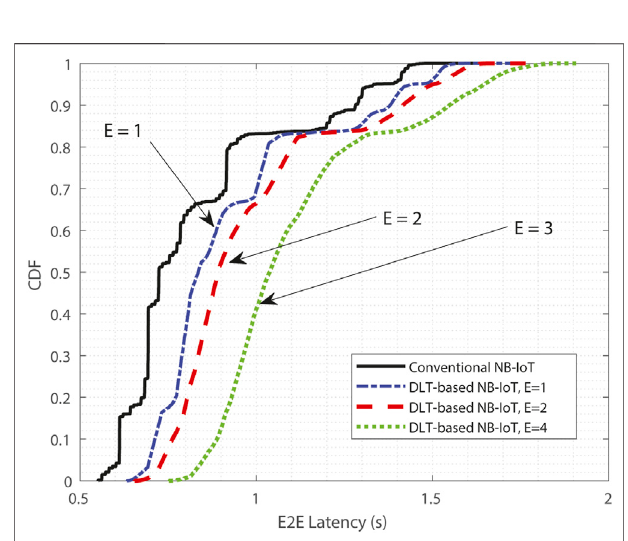
FIGURE 3 | End-to-end latency performance of the proposed integration between DLT and NB-IoT with a different number of endorsed